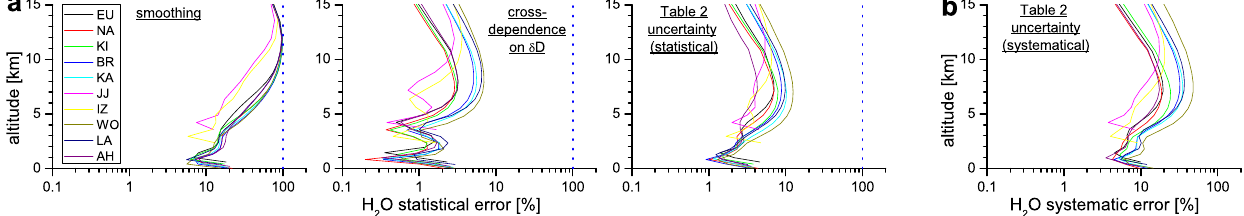
Fig. 8. Mean H 2 O profile errors as estimated for the ten stations participating in MUSICA. Panel a: Statistical errors, from the left to the right for smoothing, cross-dependence, and due to the uncertainty assumptions of Table 2. Panel b: Systematic errors for the parameter uncertainty assumptions of Table 2. The blue dashed line indicates the natural variability.